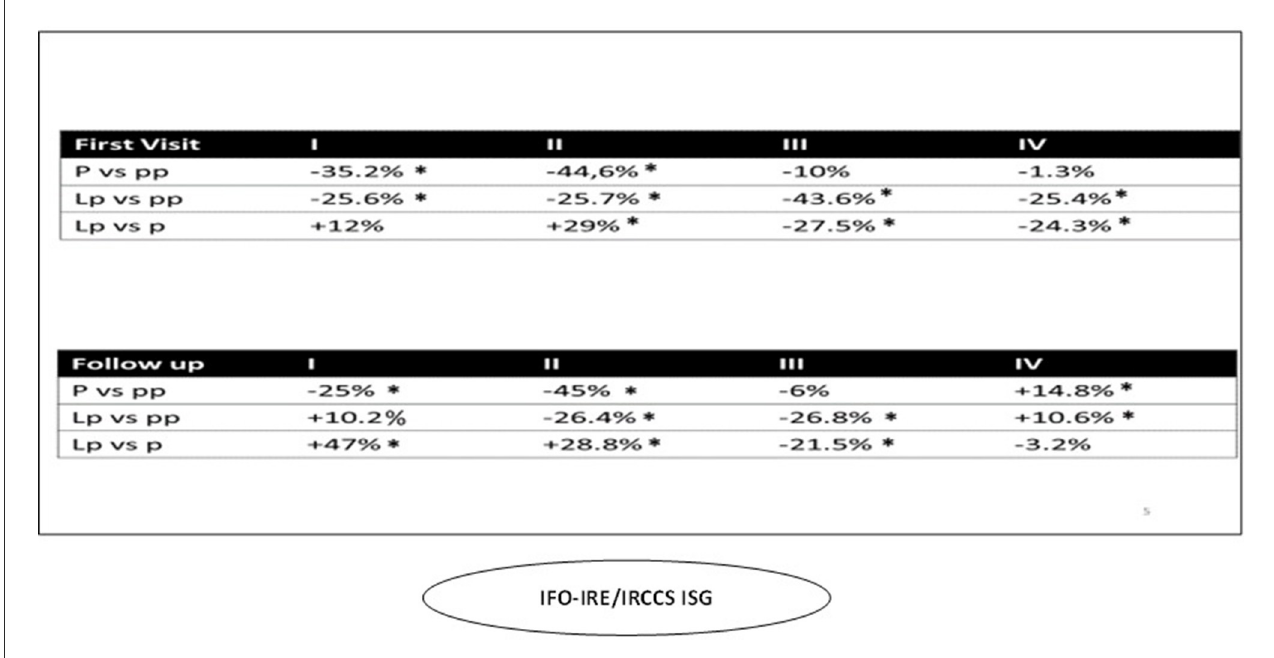
FIGURE5 Visit volume at the IRCCS IFO-IRE/IRCCS ISG (Rome) by quarter. * p < 0.005.